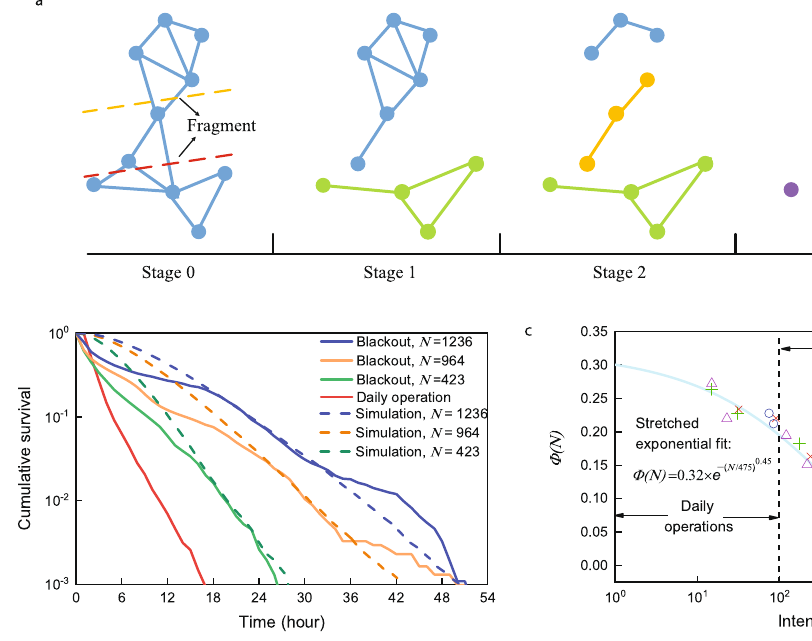
Fig. 4 | Schematic dynamics and simulation results of the cluster-based recoveryframeworktogetherwiththecomparisonofrealdata.a Illustrationof a cluster fragmentation process during outages' restoration. Each node represents an outage and each link denotes the failure dependence between two nodes. At stage1,theinitialclusterbreaksintotwosmallerclusters.Oneinbluewith6nodes and theotherone ingreen with 4 nodes. The blue cluster, with its largersize, hasa higherfragmentationratethanthegreenoneandbreaksintotwo3-nodeclustersat the next stage. At state 3, two individual nodes (red and purple) lose all of their